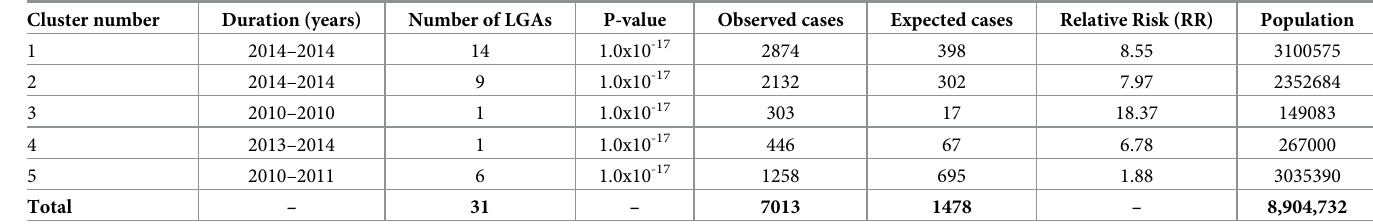
compared to the state as a whole.